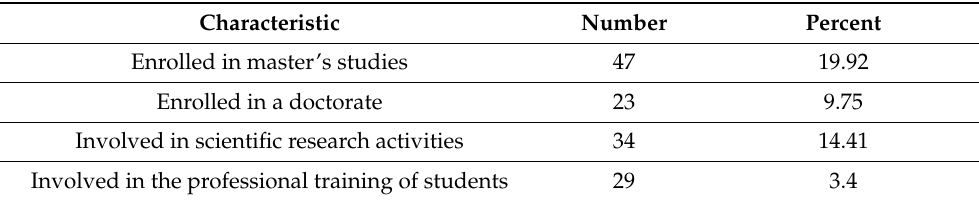
Table 2. Characteristics of the residents who managed to improve their training through academic activity.